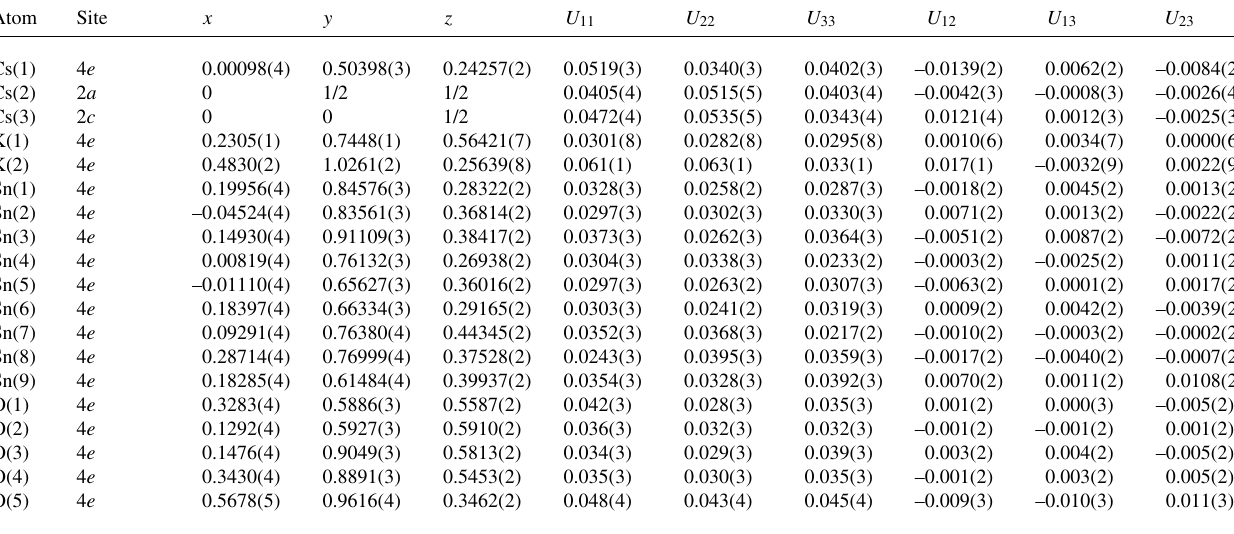
Table 3. Atomic coordinates and displacement parameters (in Å 2 ) .